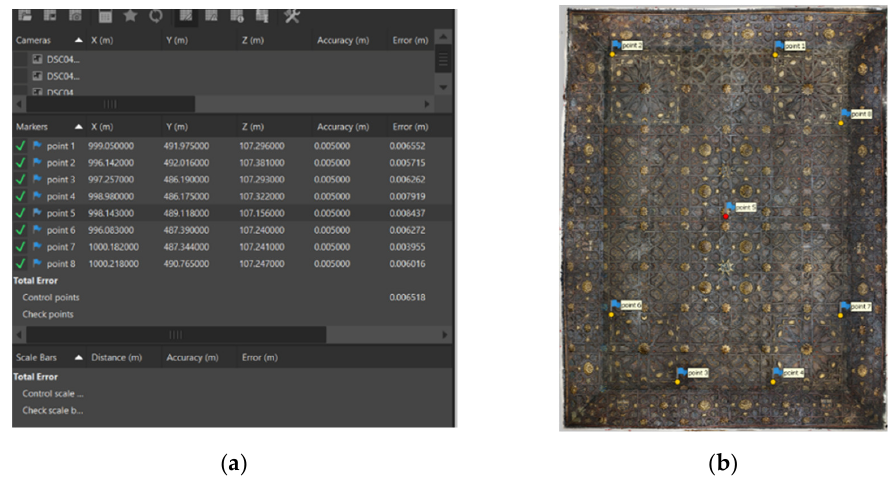
Figure 14. Photogrammetric adjustment: ( a ) Coordinates and error adjustment. ( b ) Control-point location.